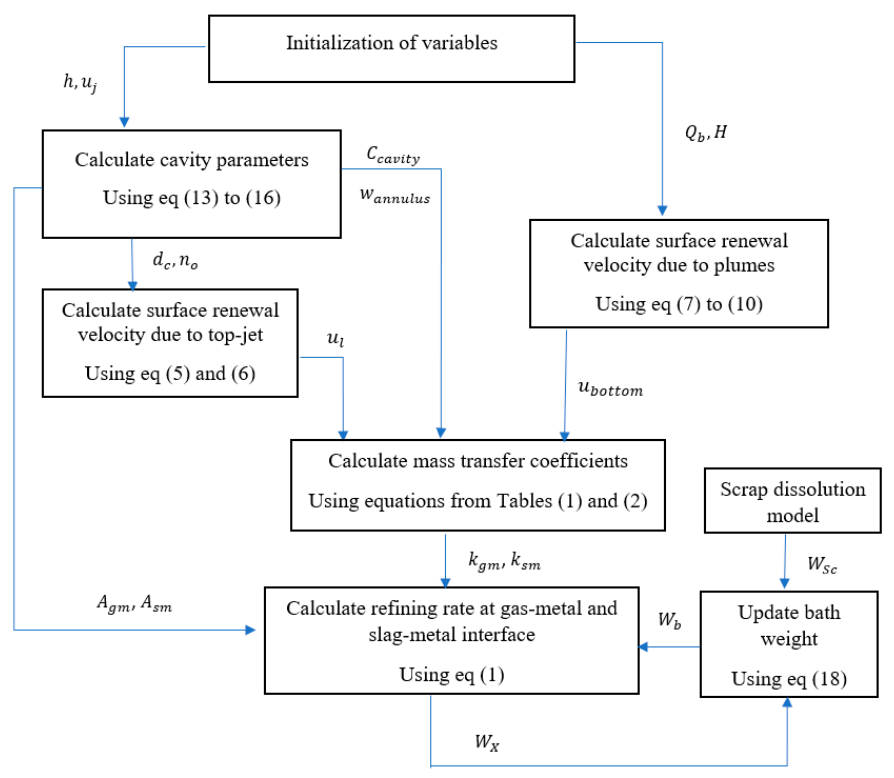
Figure 3. Schematic representation of calculation procedure for refining model.